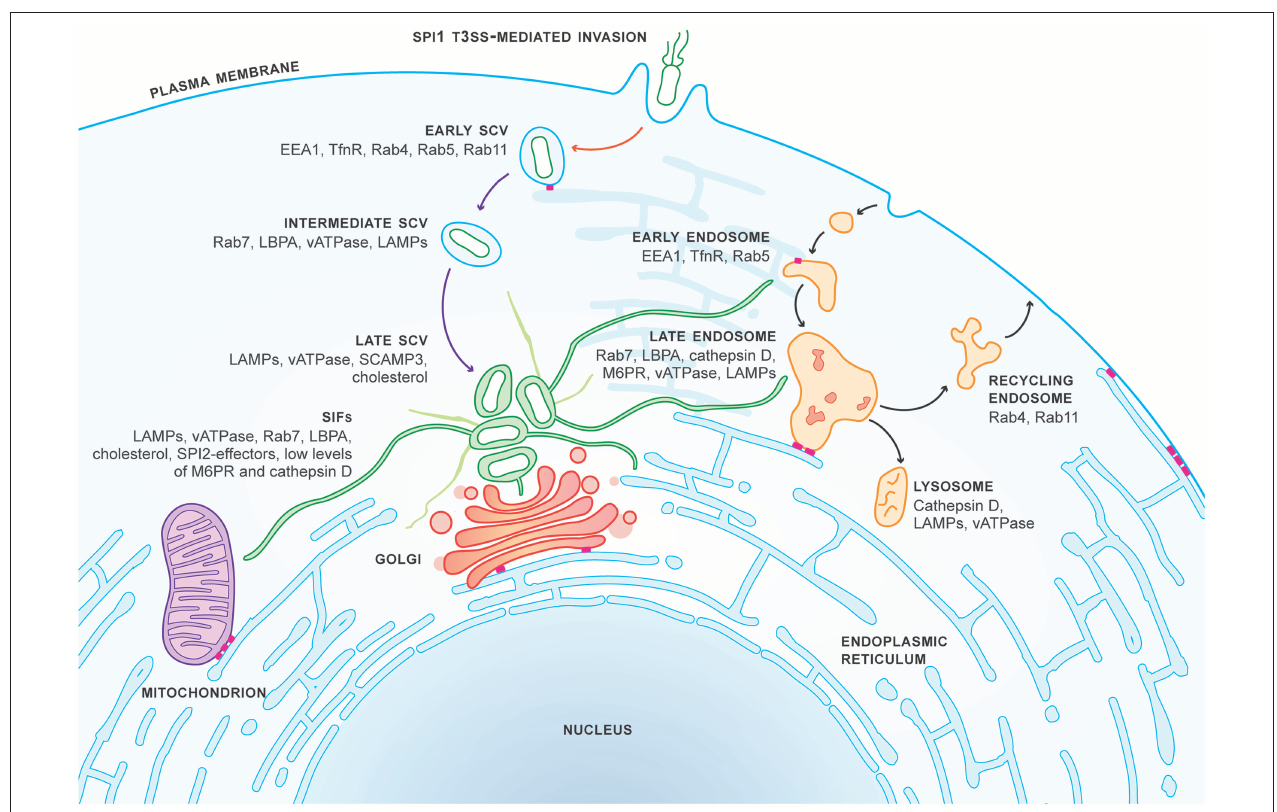
FIGURE 1 | SCV maturation and SIF biogenesis in epithelial cells. Salmonella Typhimurium invades epithelial cells in a SPI1-T3SS-dependent manner and specifically resides in the Salmonella -containing vacuole (SCV) within the host cell. Studies primarily in HeLa cells have revealed that formation of the early SCV is dependent on SPI1-T3SS-secreted effectors (red arrow) and occurs within 15 min post-invasion (p.i.). SCV maturation is dependent on SPI2-T3SS-secreted effectors (purple arrows). The late SCV is formed by 3–4 h.p.i. SCV maturation closely resembles, but is distinct from, endosome maturation (black arrows). The SCV is located next to the Golgi by 8 h.p.i., coinciding with the formation of Salmonella -induced filaments (SIFs, green tubules). SIFs form an extensive network throughout the host cell facilitating interactions with host organelles. The tubular endoplasmic reticulum network (blue tubules) forms multiple contact sites (MCSs, pink bars) with organelles, the plasma membrane, and the early